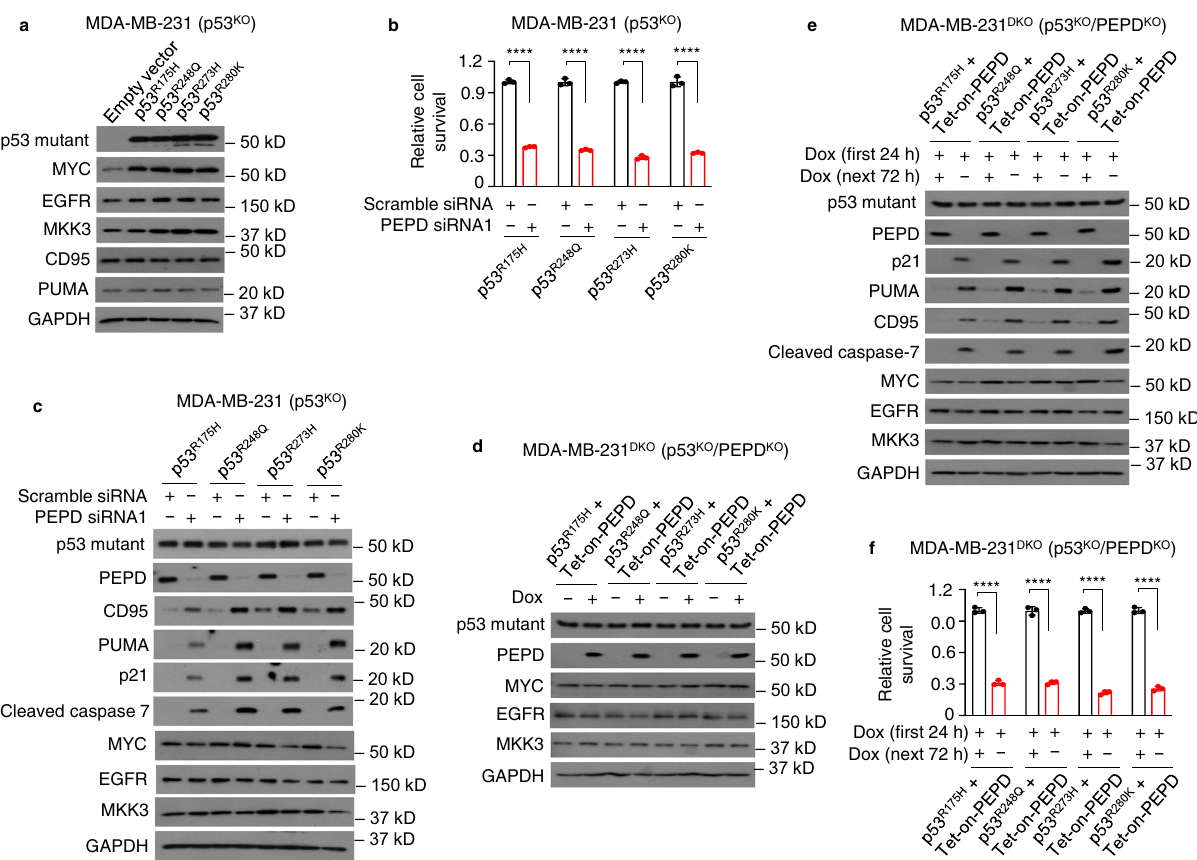
Fig. 4 PEPD is not required for the oncogenic functions of p53 mutants, and reactivated p53 mutants dominate their unreactivated counterparts. a MDA-MB-231 (p53 KO ) cells were transfected with or without a p53 mutant for 48 h. p53 mutant and other proteins in WCL were analyzed by WB. b , c MDA-MB-231 (p53 KO ) cells were transfected with a p53 mutant and 24 h later treated with siRNA (10 nM) for 96 h. The relatively long siRNA treatment time was for harvesting enough cells for analysis. Cell viability was measured by trypan blue assay in b . p53 mutant and other proteins in WCL were analyzed by WB in c . d MDA-MB-231 DKO cells (p53 KO and PEPD KO ) were cotransfected with a p53 mutant and Tet-on-PEPD and treated with or without Dox (50 ng/ml) for 48 h. p53 mutant and other proteins in WCL were analyzed by WB. e , f MDA-MB-231 DKO cells were transfected with a p53 mutant and Tet-on-PEPD, treated with Dox (50 ng/ml) for 24 h, washed, and cultured with or without Dox (50 ng/ml) for 72 h. p53 mutant and other proteins in WCL were analyzed by WB in e . Cell viability was measured by trypan blue assay in f . GAPDH is a loading control in a and c – e . The bar-dot plots in b and f show individual values and mean ± SD ( n = 3). **** P < 0.0001, by paired two-tailed t